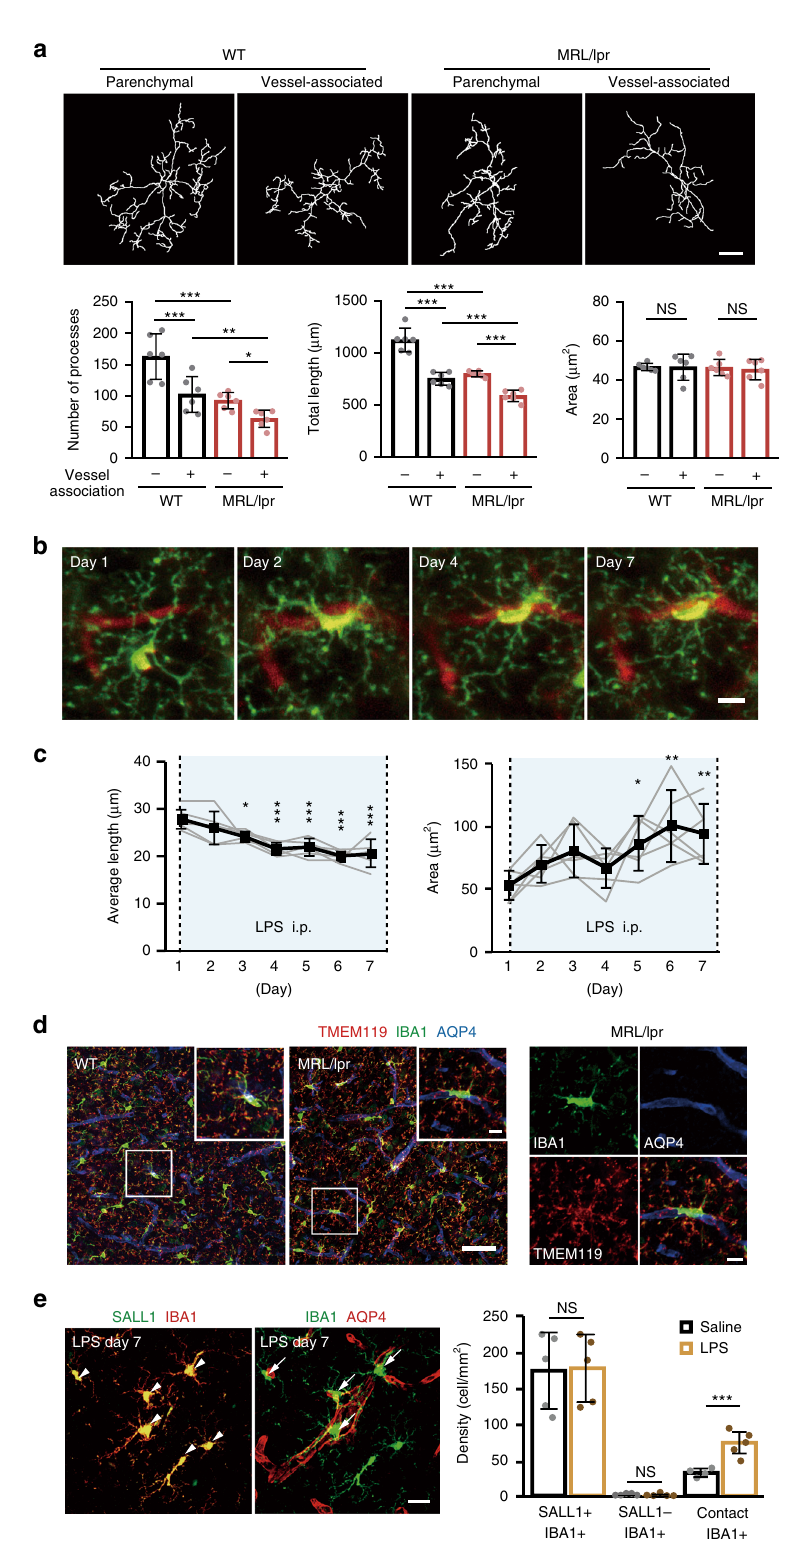
Microglia express phagocytic proteins in late in fl ammation . As indicated above, the gene analysis had also suggested expression of the phagocytic marker CD68 in MRL/lpr mice microglia (Supplementary Fig. 6), so we next focused on the characteristics and functional consequences of this. Immunohistochemistry demonstrated increased CD68 + ’ ve and IBA1 + ’ ve cells, both in